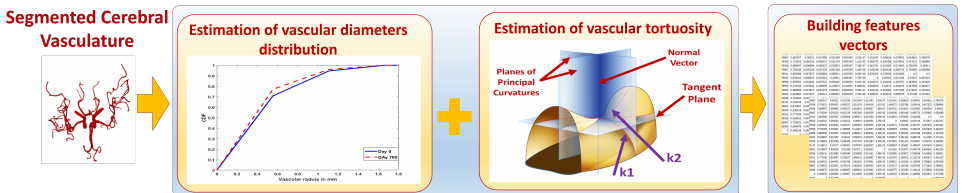
Figure 5. Module 2: Estimation of descriptive vascular features and building feature vectors.